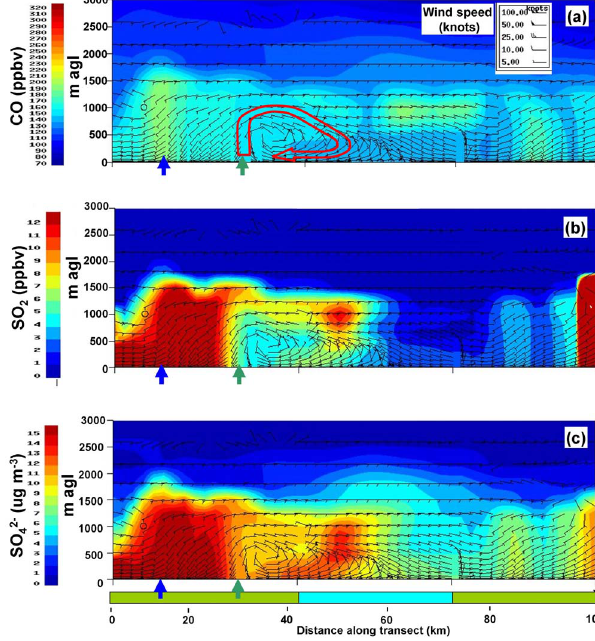
Fig. 8. Vertical cross section for model-predicted (a) CO and (b) SO 2 and (c) SO 2 − at 12:00LT along the axis of the aircraft tran- 4 sect (dashed red line in Fig. 7). Wind direction overlaid is the 3-D wind field in the plane of the cross-section and, thus can be used to indicate horizontal and vertical motion in the plane of the cross- section. Red arrow in panel (a) represents the LSC lake-breeze mo- tions. Land=green bar; lake=blue bar. Coloured arrows indicate lake breeze fronts (blue=LE,